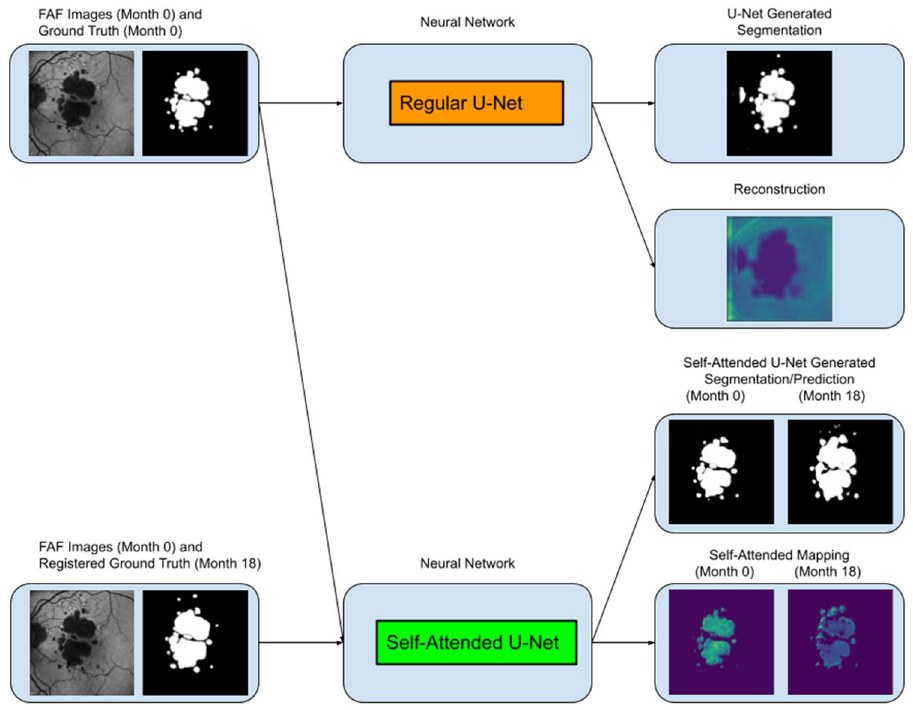
Figure 1. Overview of the entire atrophy segmentation and prediction system using regular U-Net and self- attended U-Net with AMD data as an